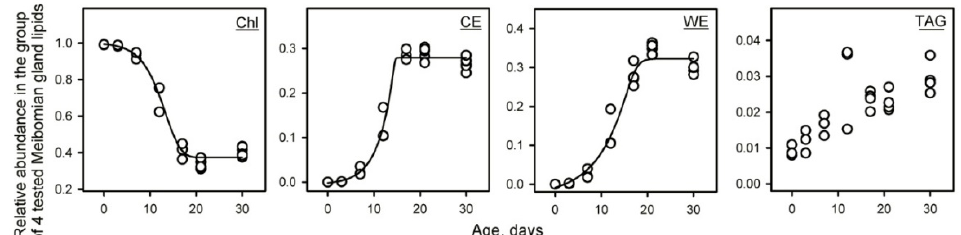
Figure 4. Dynamic changes in the lipid profiles of four typical Meibomian lipids—free cholesterol (Chl), a C 28:1 FA-based cholesteryl ester (CE), a C 26:0 /C 16:1 wax ester (WE), and triolein (TAG). The data were normalized so that the total sum of four lipids equals unity. Note a complete absence of the extremely long-chain WE and CE at P0, a noticeable lag in the increases in the CE and WE content during the first few days of maturation, and their exponential growth from P3 to P17. Each data point represents an individual sample from an individual mouse.